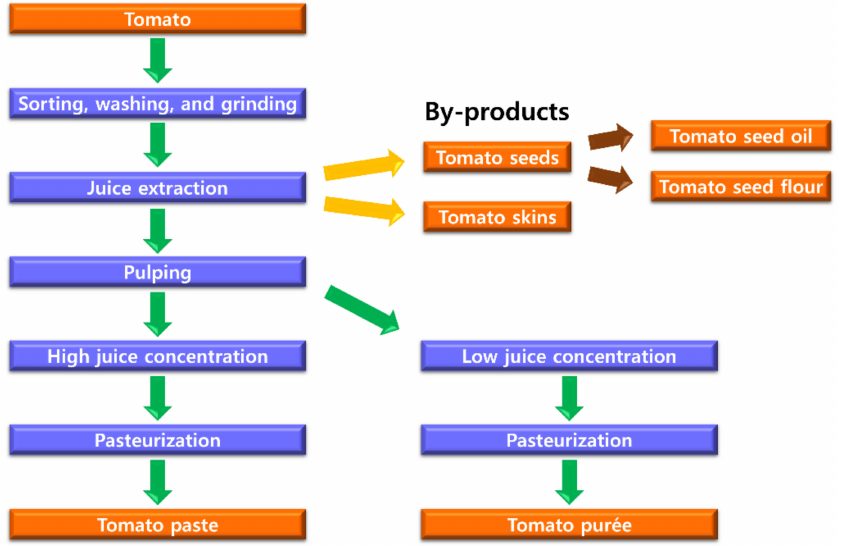
Figure 1. Tomato pur é e and paste processing scheme. Tomato seeds can be further processed into tomato seed oil and